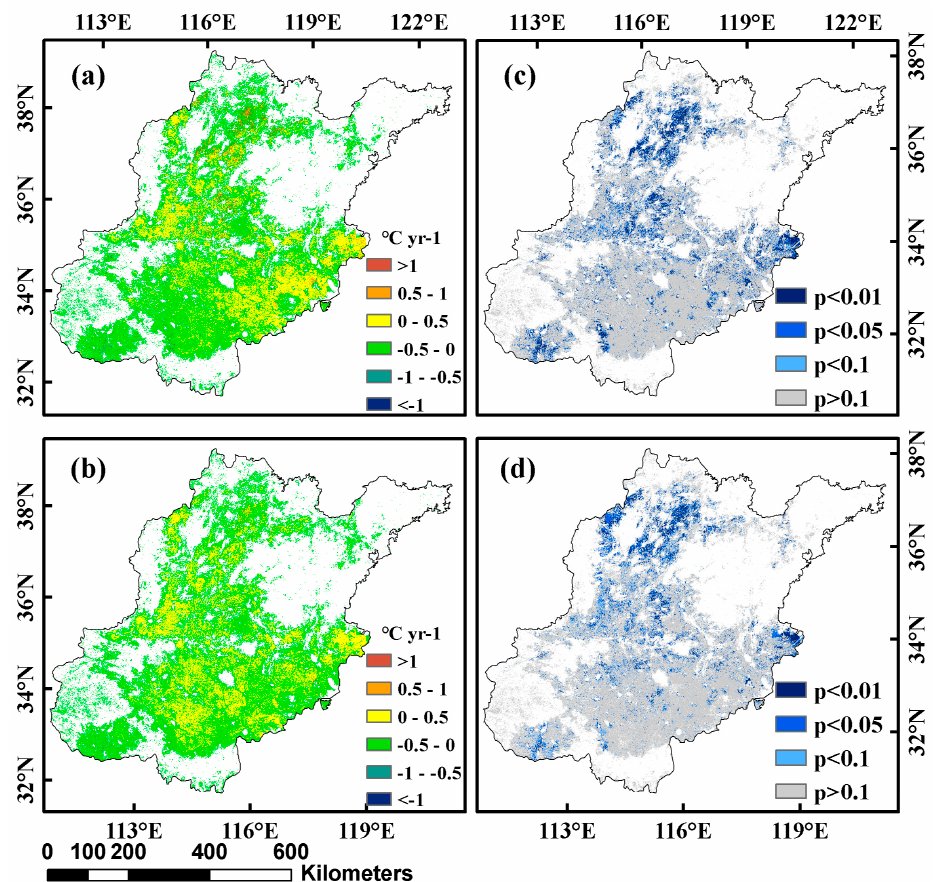
Figure 7. The changes in two-month mean temperature in March–April ( a ) and May–June ( b ) during 2003–2018 at di ff erent significance levels ( c , d ). The gray pixels represent where the changes are not significant ( p >